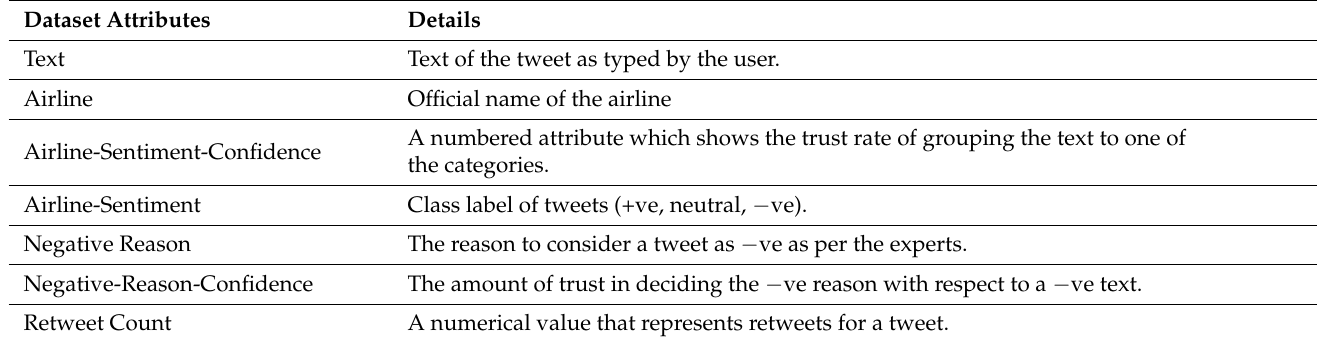
Table 13. Feature description of selected